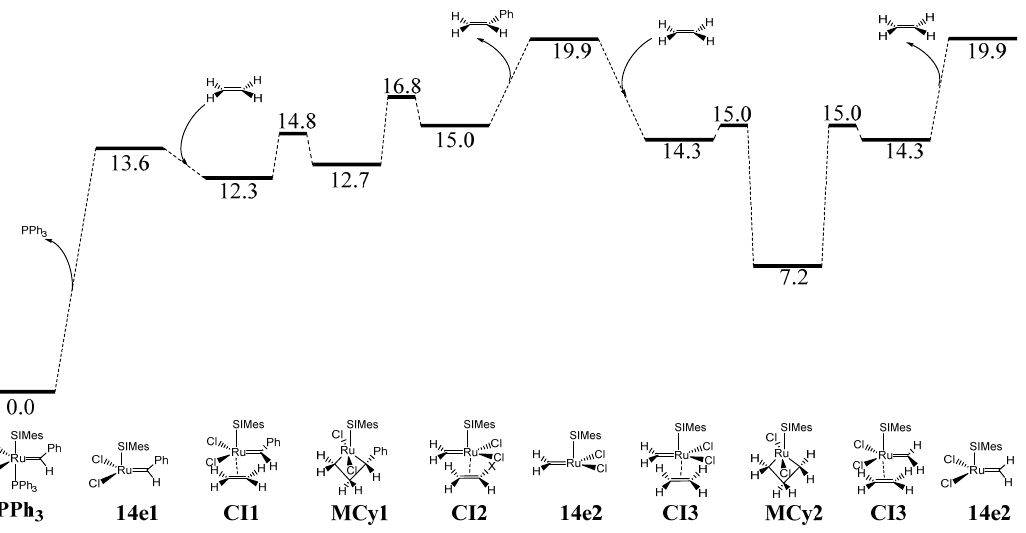
Figure 4. In-solvent (CH 2 Cl 2 ) free-energy profile for the olefin metathesis reaction of complex B ( B = PPh 3 here) using ethylene as a substrate (calculated Gibbs energies at 298.15 K given in kcal/mol, SIMes = 1,3-Bis(2,4,6-trimethylphenyl)-4,5-dihydroimidazol-2-ylidene). The preferred trans mode is displayed.